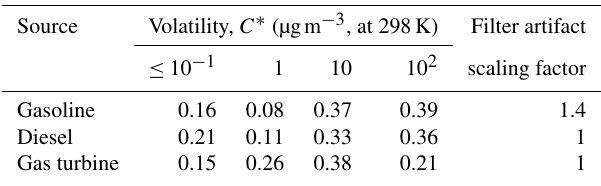
Table 3. POA volatility distributions and filter artifact scaling fac-